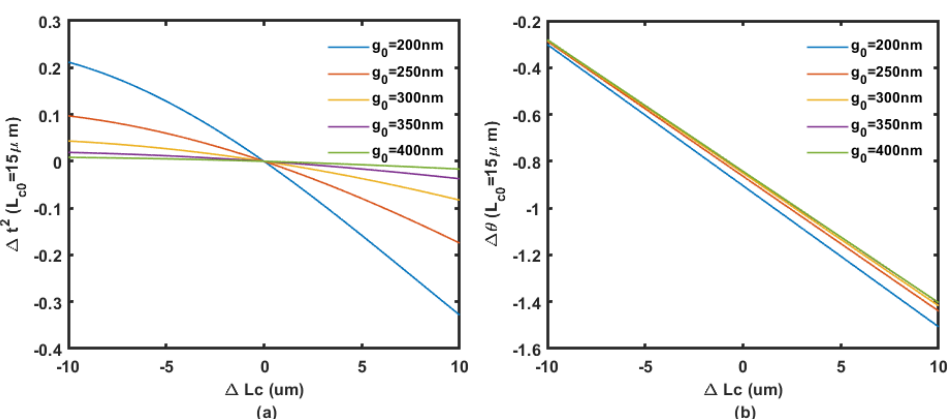
Figure 5. Coupling ( a ) and phase ( b ) change regarding the displacement in coupling length with 15 µ m initial length at different coupling gaps from 200 nm to 400 nm.